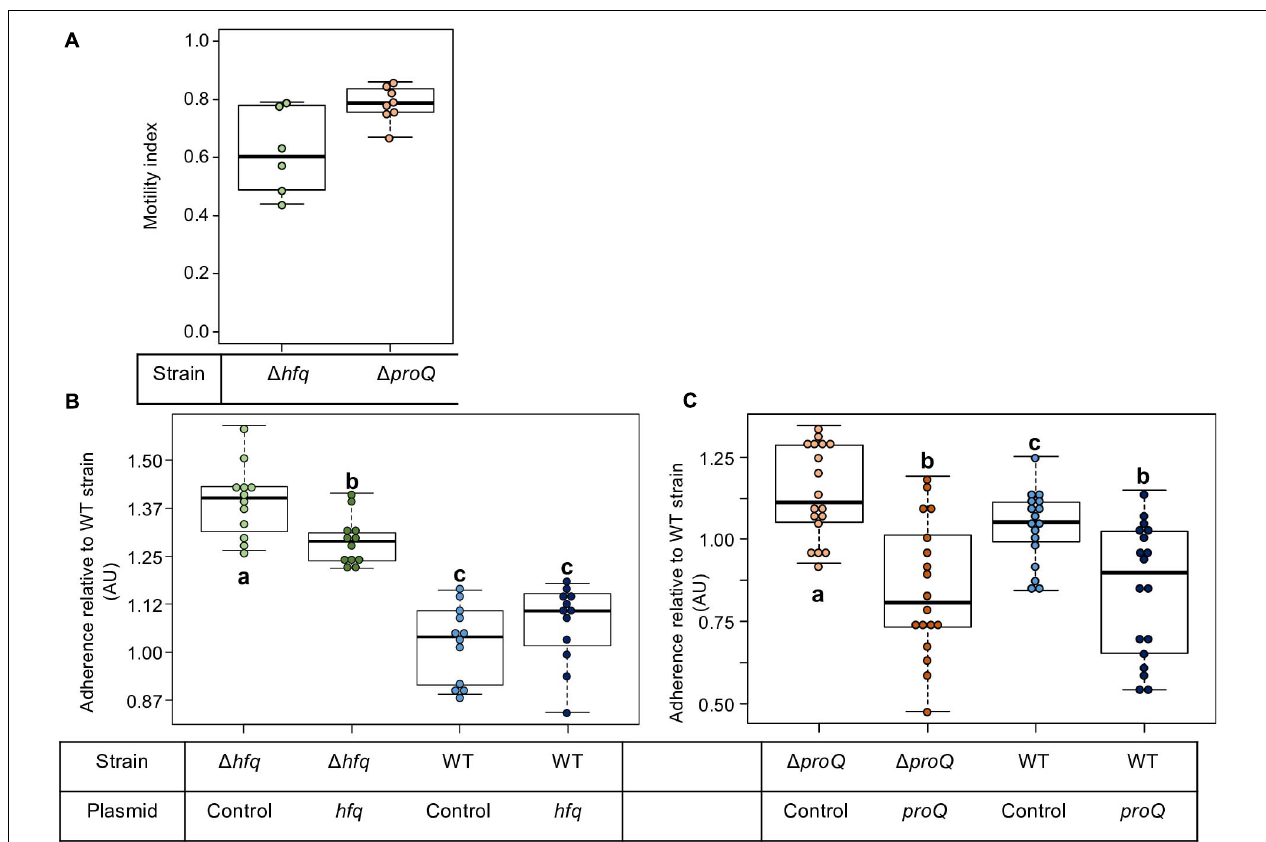
FIGURE 4 | Impact of Hfq and ProQ on motility and biofilm formation. (A) Motility indexes of the hfq and proQ mutants. Motility experiments were performed in capillary assays for the hfq mutant and in soft agar plates for the proQ mutant. The motility index was equal to the motility results of the mutant strain (number of cells in the capillary or halo size) divided by the results of the WT strain. (B,C) Impact of the hfq and proQ mutations on biofilm formation. Assays were carried out in multi-well plates. Data were normalized relative to the adherence of the wild-type strain. The effect of heterologous complementation is also showed. Quantification of the cells present in the aggregates and in the planktonic fractions for the different strains. Experiments were repeated at least three times. Non-capital letters a, b, and c are presented above the boxplots. Groups with the same letter are not detectably different (are in the same set) and groups that are detectably different get different letters (different sets). Note that if the groups have the same letter, this does not mean they are the same, just that there is no evidence of a difference for that pair ( P < 0.05, Wilcoxon Mann-Whitney